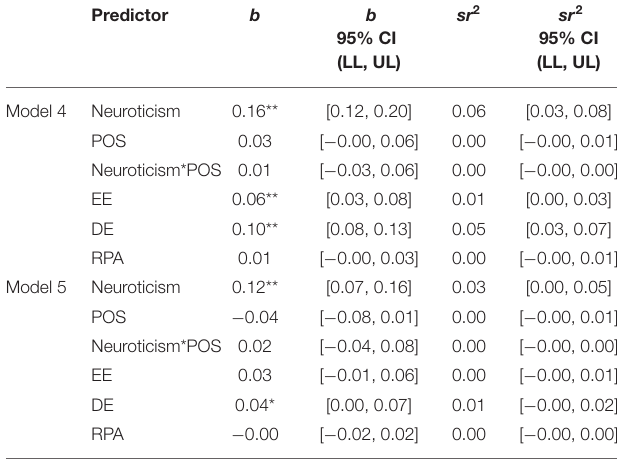
TABLE 3 | Regression results using SAS (Model 4) and SDS (Model 5) as the criterion. Predictor